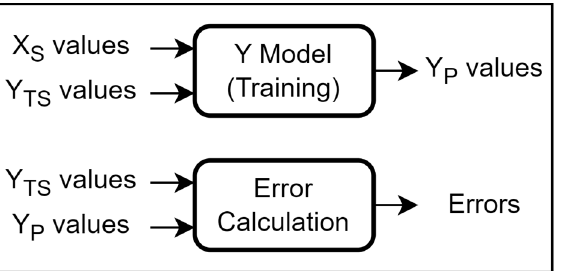
Figure 6. Steps for the training process and the evaluation of the Y model.